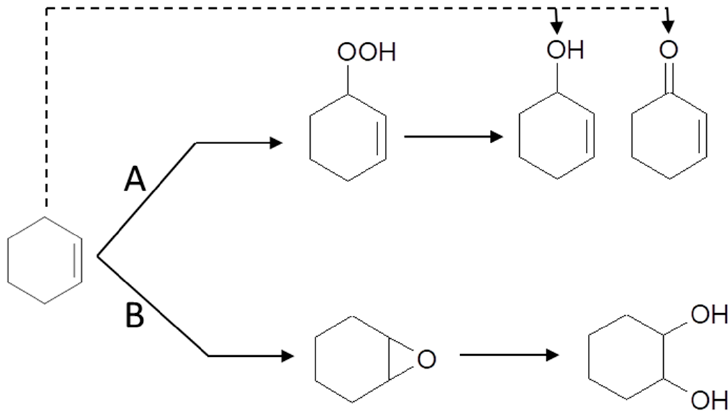
Figure 10. Scheme of the reaction pathway for cyclohexene oxidation under the conditions prevalent in this work.